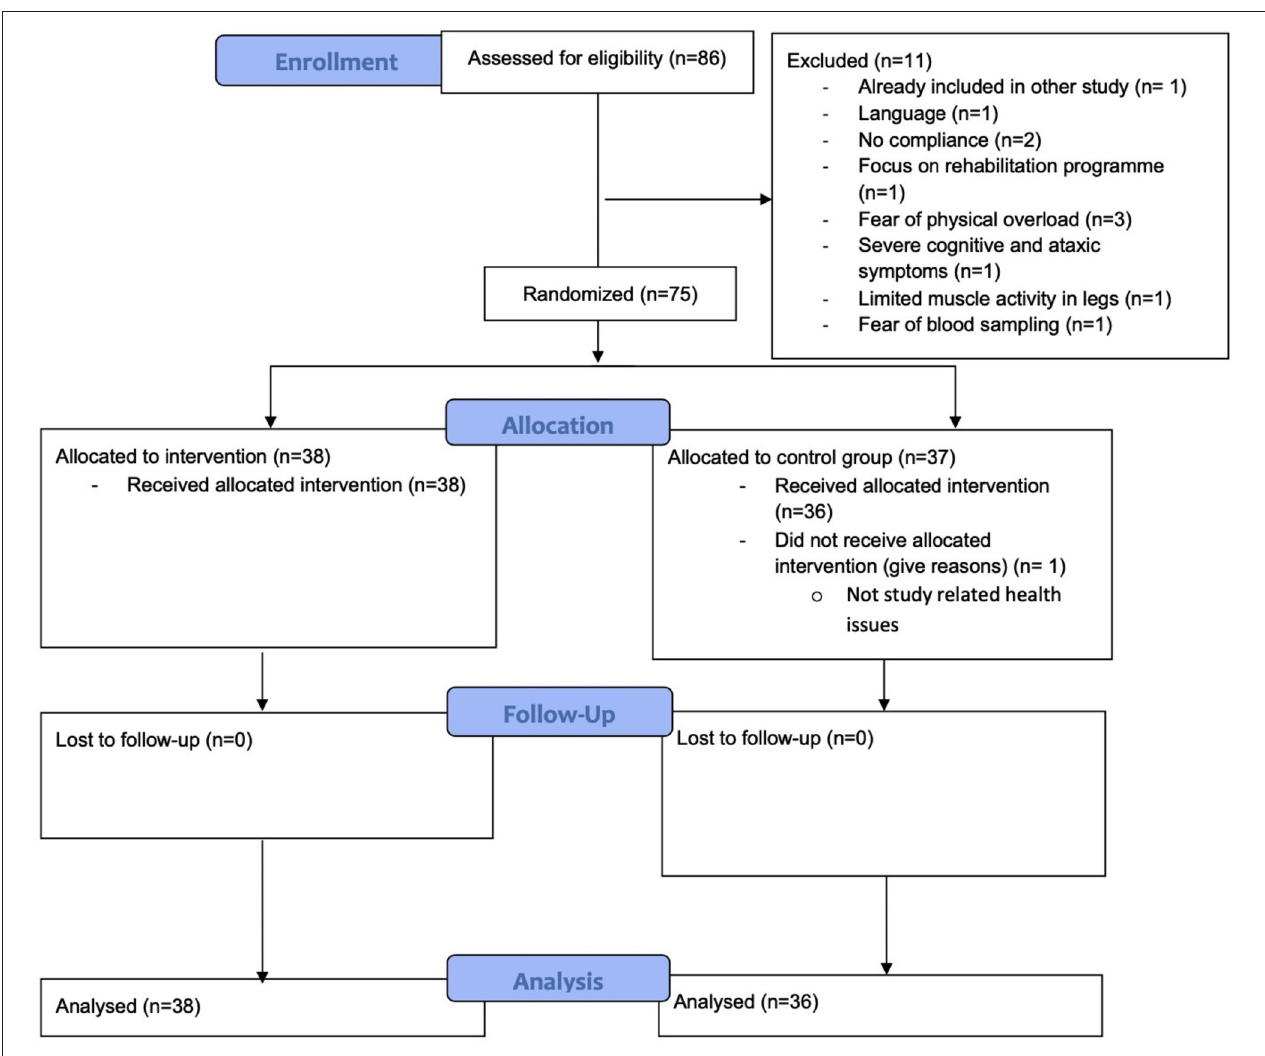
FIGURE 1 | Participant flow